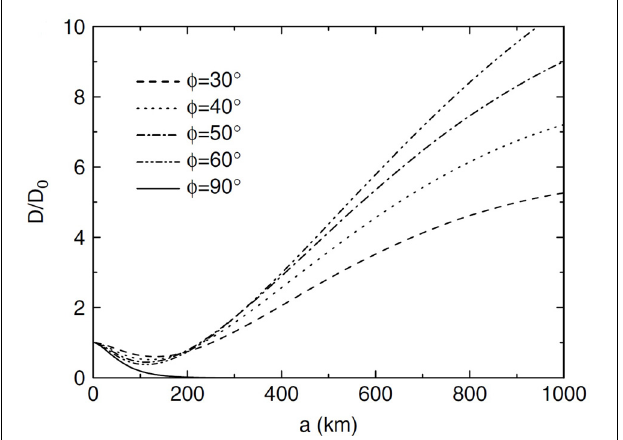
FIGURE 13 | Drag normalized by (31) as a function of the mountain width in the zonal direction for γ = 0 . 25 and latitudes ( φ ) between 30 o and 90 o (see legend for details). Reproduced from Figure 3 of Teixeira and Grisogono [137]. Copyright © 2008 Royal Meteorological